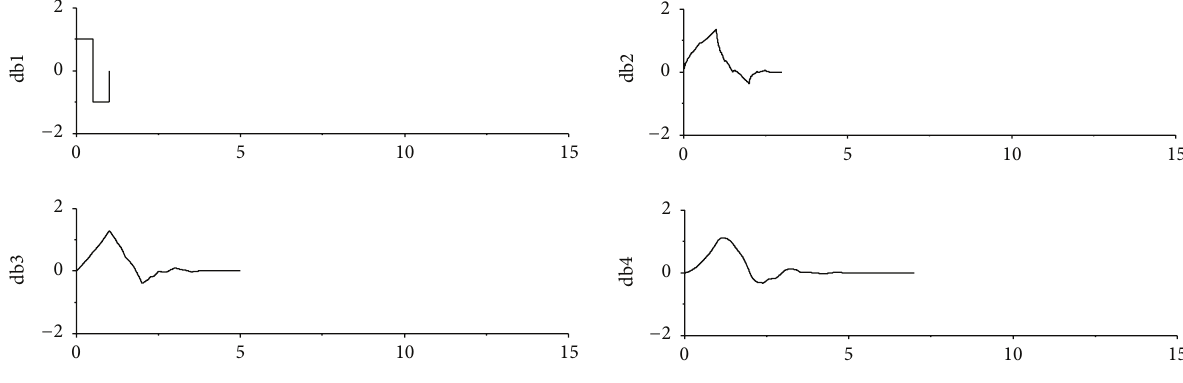
Figure 7: The Daubechies wavelets